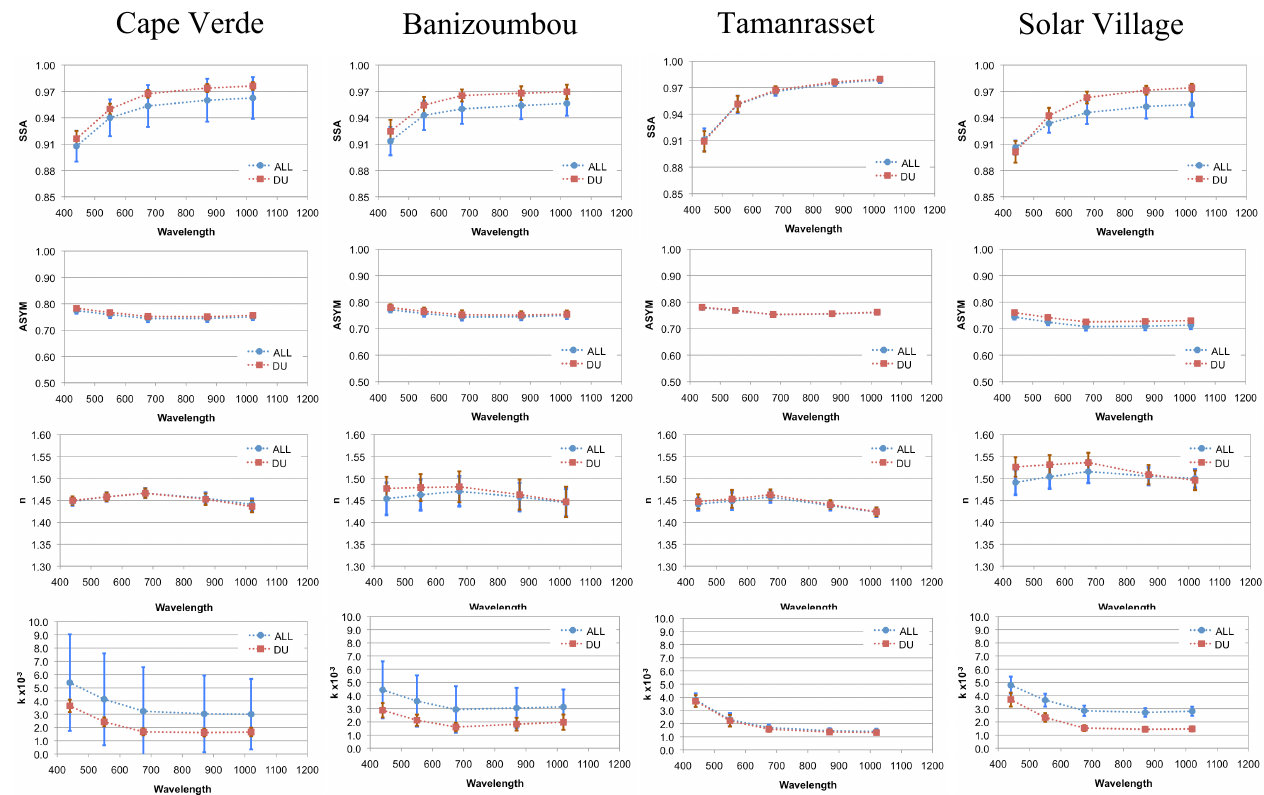
Fig. 3. Wavelength dependency of DU optical properties at four selected